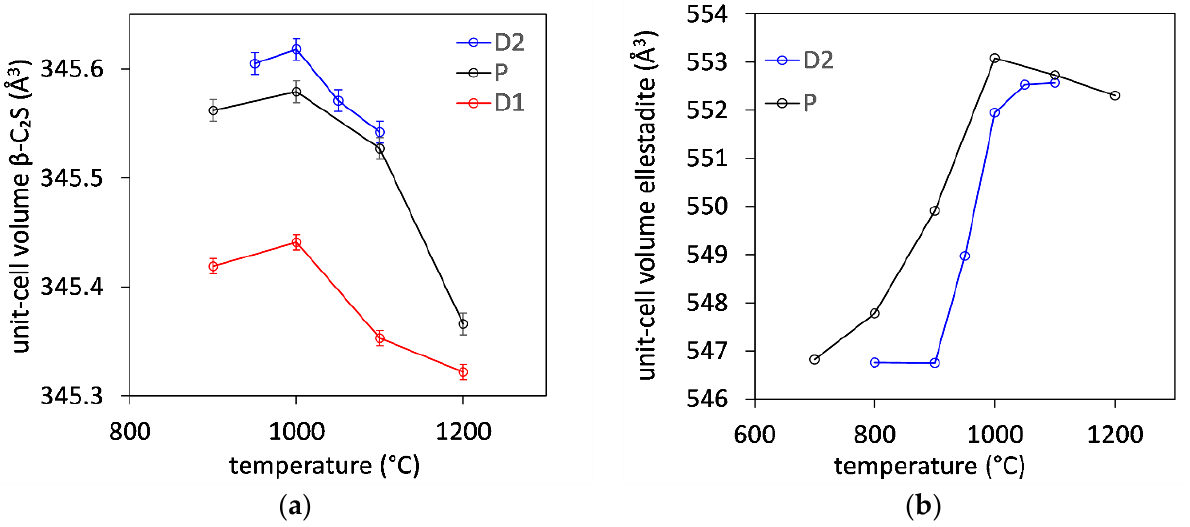
Figure 3. Variation in the unit- cell volumes of β -C 2 S with synthesis temperature for phase contents > 25 wt% ( a ). Maximum e.s.d.s of Rietveld refinements are provided as error bars. Variation in the unit-cell volumes of ellestadite contents in samples D2 and P ( b ) . E.s.d.s ≤ symbols.